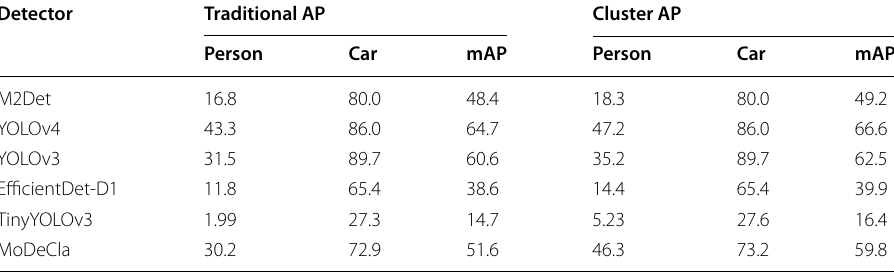
Table 5 AP values computed from the Traditional and Cluster precision-recall curves on the Summer benchmark set Detector Traditional AP Cluster AP Person Car mAP